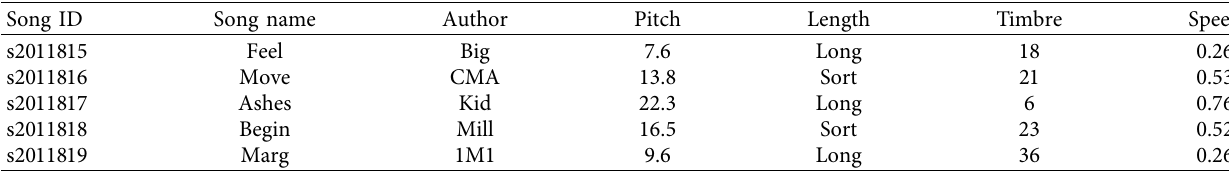
Table 3: Information of C2 music works.